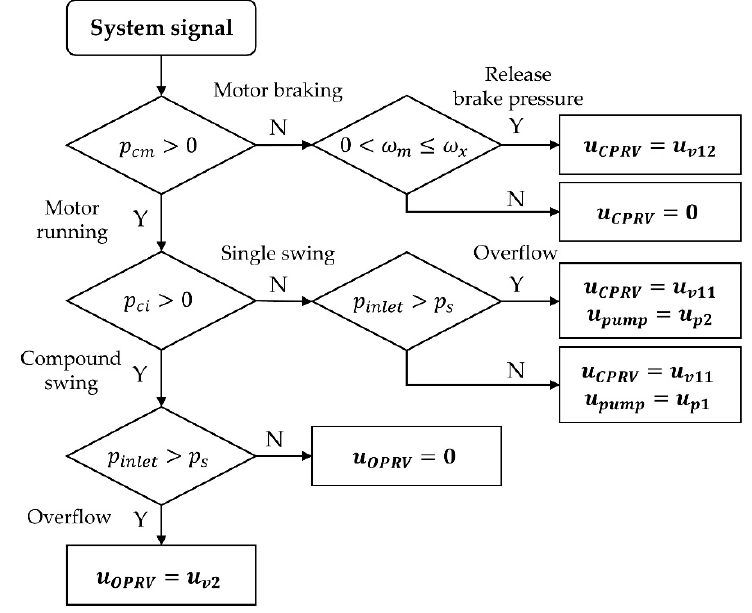
Figure 7. Flowchart of motor control strategy.